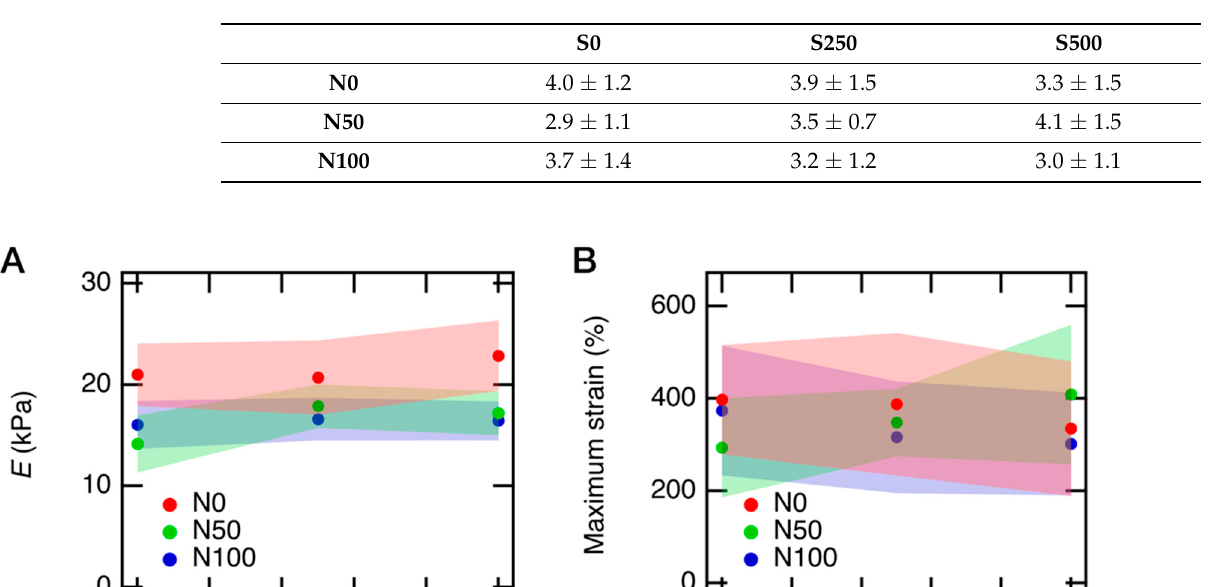
Table 2. The average value and the standard deviation for the maximum strain of PAA gels at each condition.